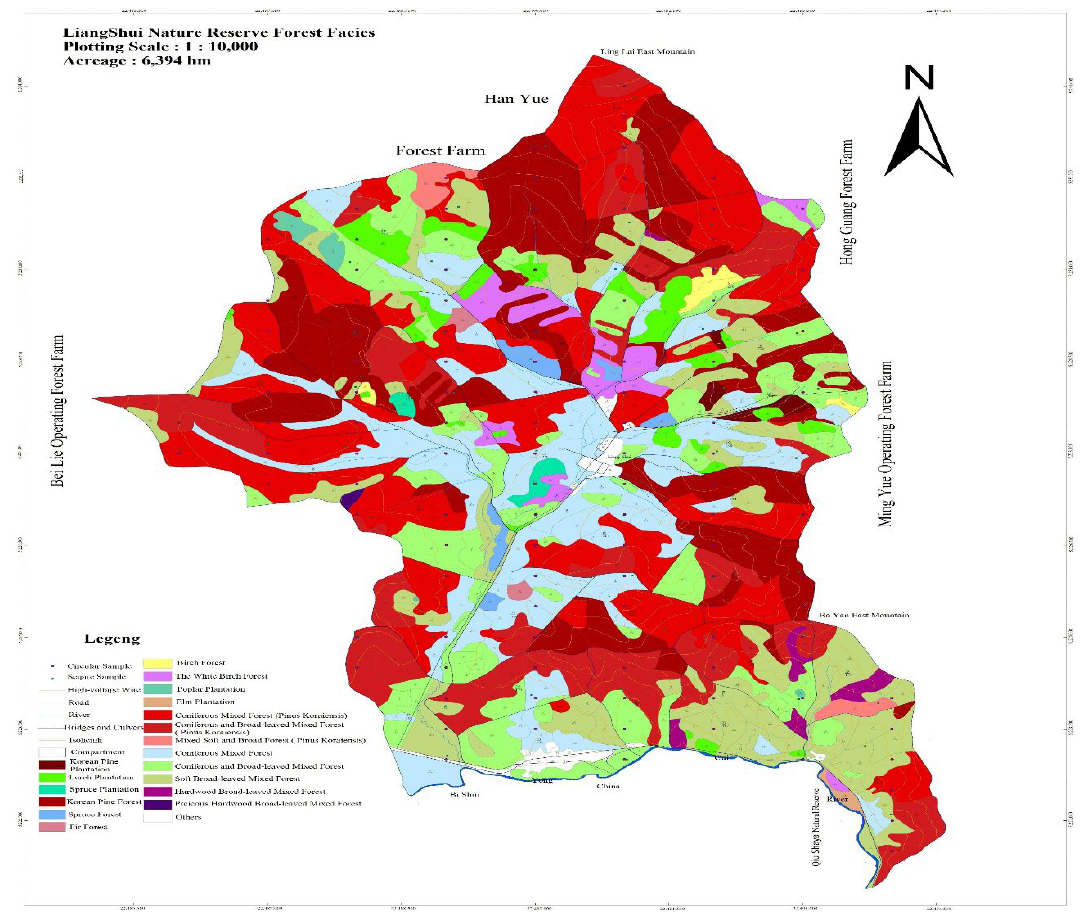
Figure 1. A map of forest distribution in Liangshui National Nature Reserve of Northeast China.